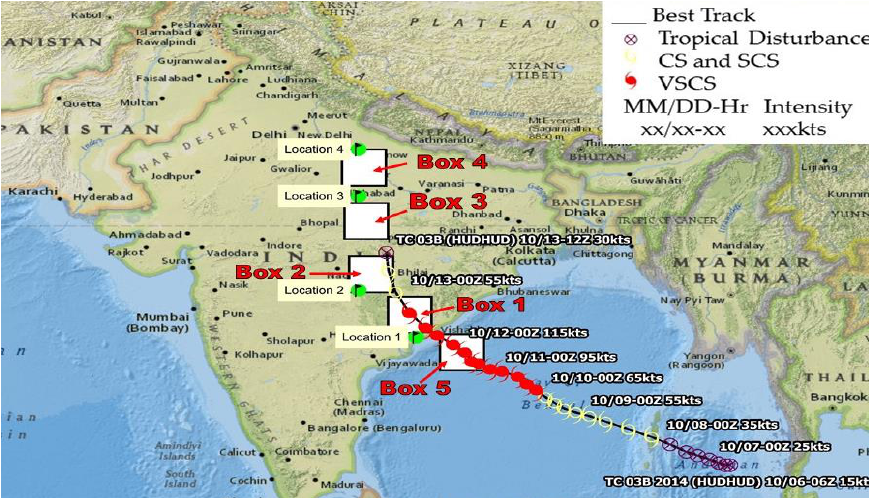
Figure 1. The Hudhud cyclone track during 7–13 October 2014; the cyclone moved northward after landfall, damaging large areas from heavy rainfall. The track is shown from the day of the cyclone formation (7 October 2014) until 13 October 2014 (track of cyclone shown in this figure is taken from Joint Typhoon Warning Centre, (//www.usno.navy.mil/NOOC/nmfc-ph/RSS/jtwc/best_tracks/2014/2014s-KMZs/JTWC_BestTrack_Climatology_2014.kmz). The white squares show the location of five 2 ◦ × 2 ◦ boxes, as shown in Table 1, and four locations, as shown in Table 2, for the detailed analysis of various parameters. CS: cyclonic storm; SCS: severe cyclonic storm; VSCS: very severe cyclonic